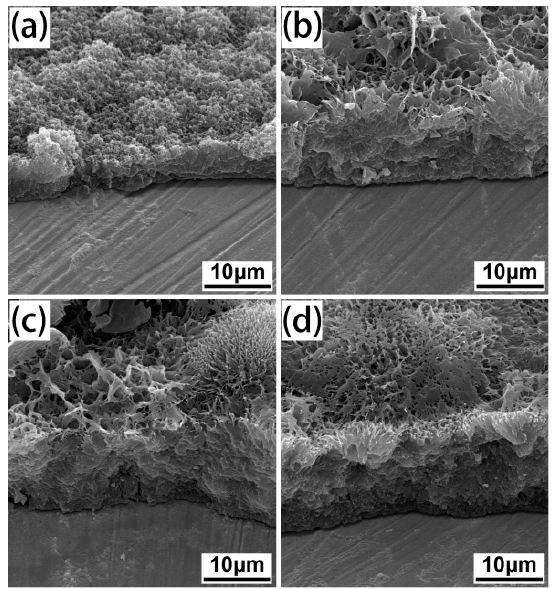
Figure 4. The 45° rotation surface morphologies of the coated specimens deposited at different times: ( a ) 3 min, ( b ) 15 min, ( c ) 30 min, ( d ) 60 min. ( a ) 3 min, ( b ) 15 min, ( c ) 30 min, ( d ) 60